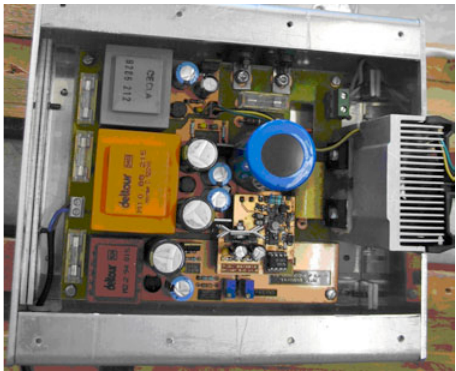
Figure 3: SiC- B uck converter. The common mode (CM) and differential mode (DM) currents are measured using current probes on the supply wires between the LISN and the converter as shown in figure 4.